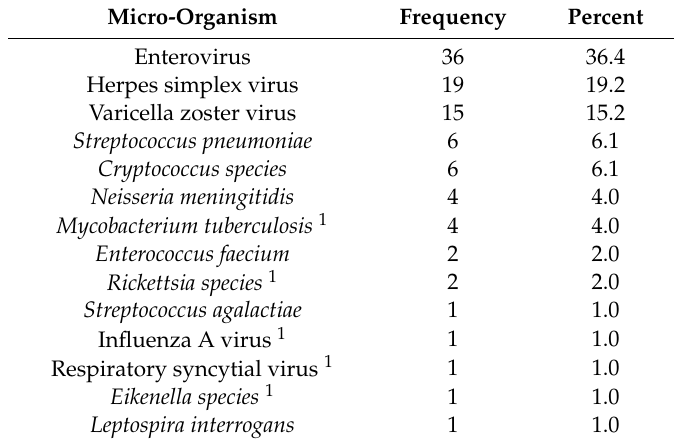
Table 2. Micro-organisms isolated in 99 patients by